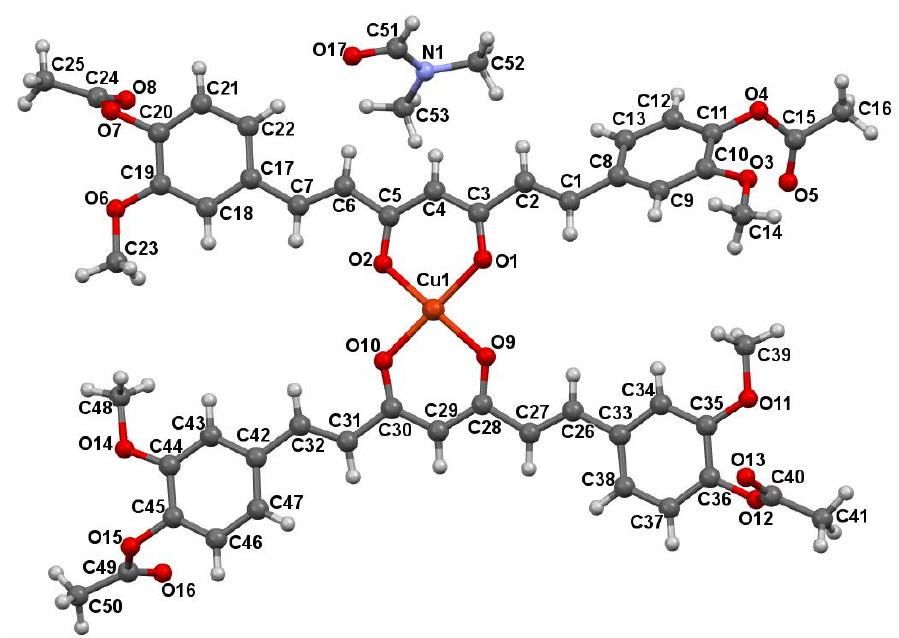
Figure 4. Molecular structure of 4 . Hydrogen atoms are drawn as circles with an arbitrary radius.